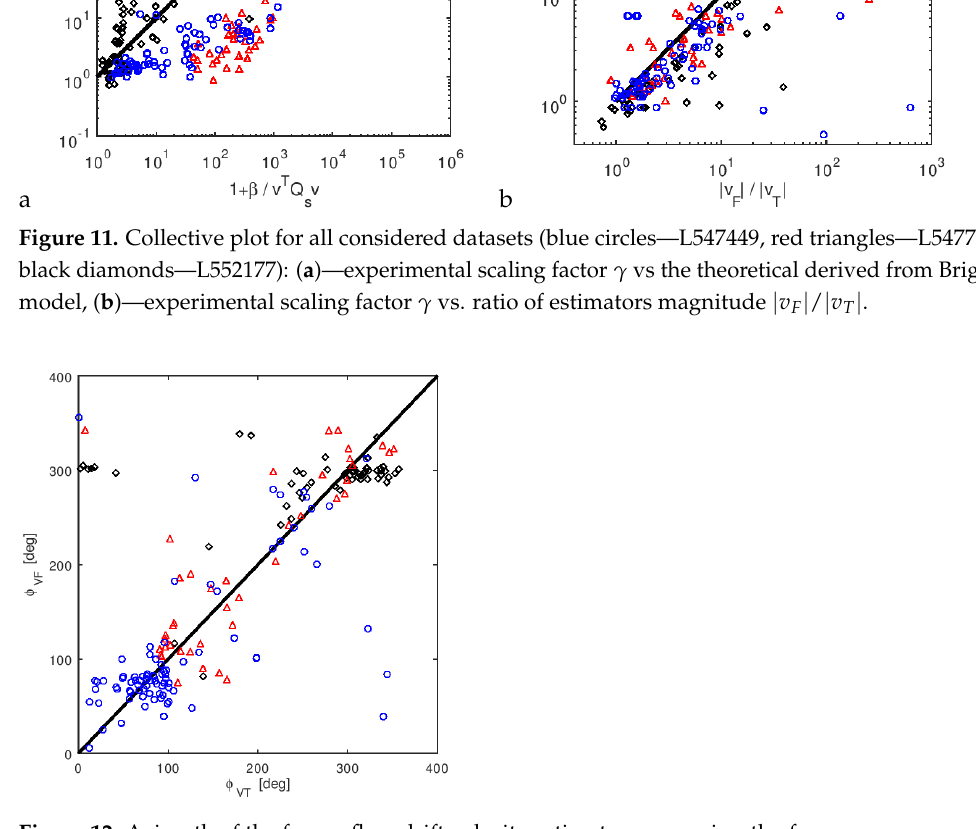
Figure 12. Azimuth of the frozen flow drift velocity estimate v F vs. azimuth of v T .